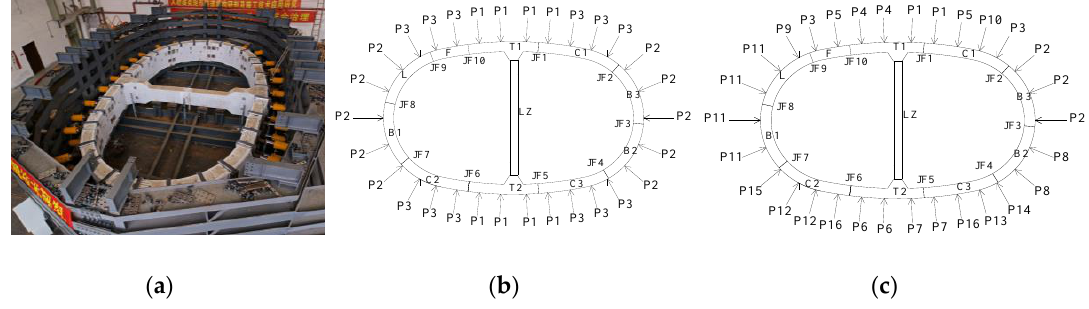
Figure 10. Indoor full-ring experiment: ( a ) loading frame; ( b ) jack distribution for Experimental Cases 1 and 2; ( c ) jack distribution for Experimental Case 3.